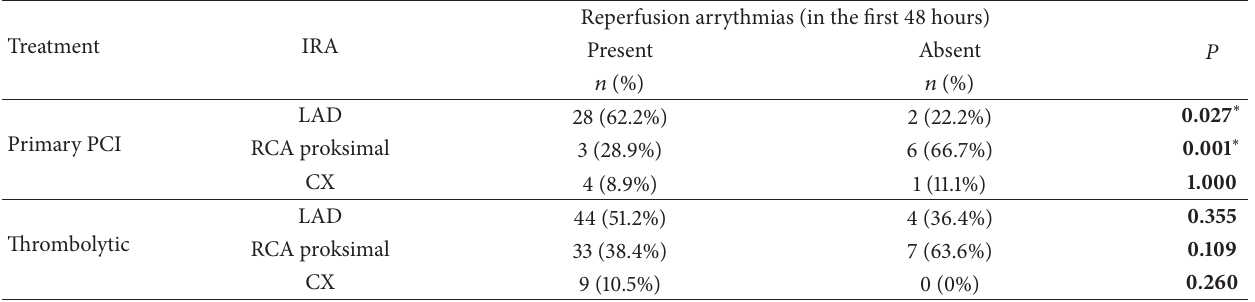
Table 7: Infarct related artery and presence of reperfusion arrythmias in both treatment groups.